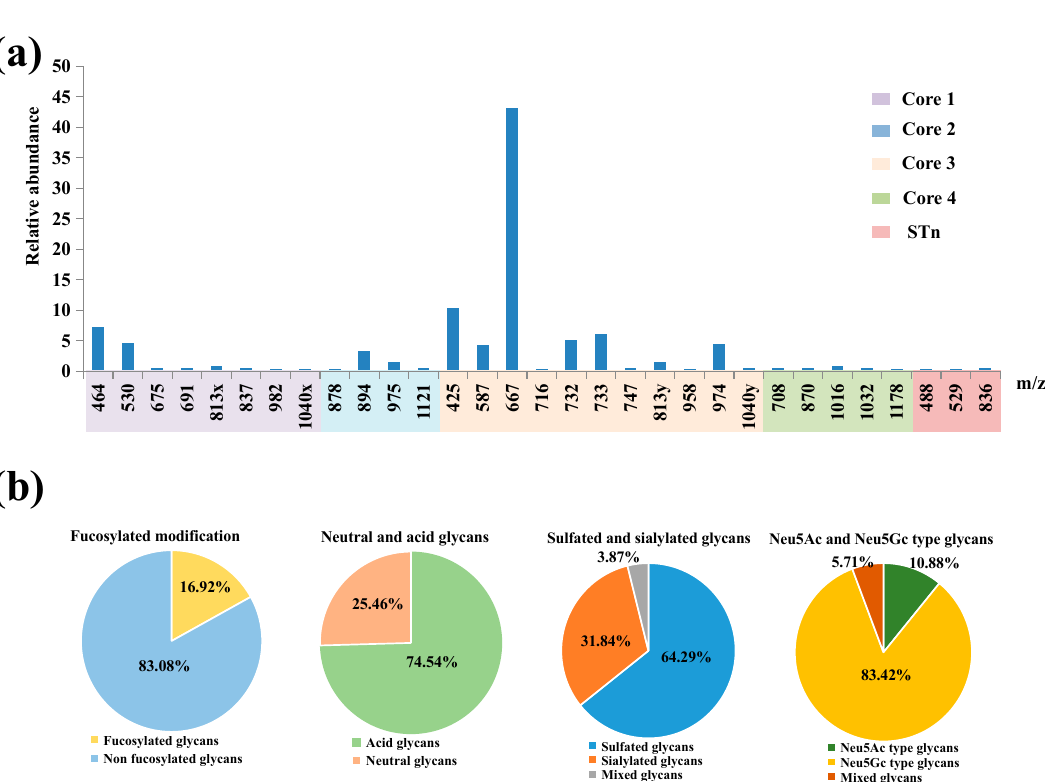
Figure 1. Composition and content of O -glycans. ( a ) Quantitative graph of 33 kinds of O -glycans existed in rabbit intestines. ( b ) Percentage of different types of O -glycans with various modifications.